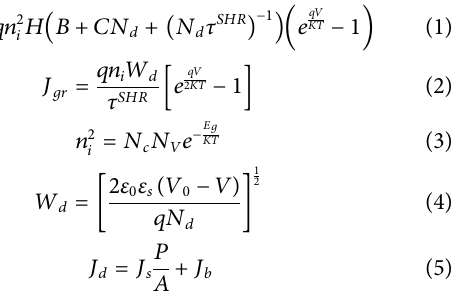
FIGURE 5 | Packaged FPA chip.